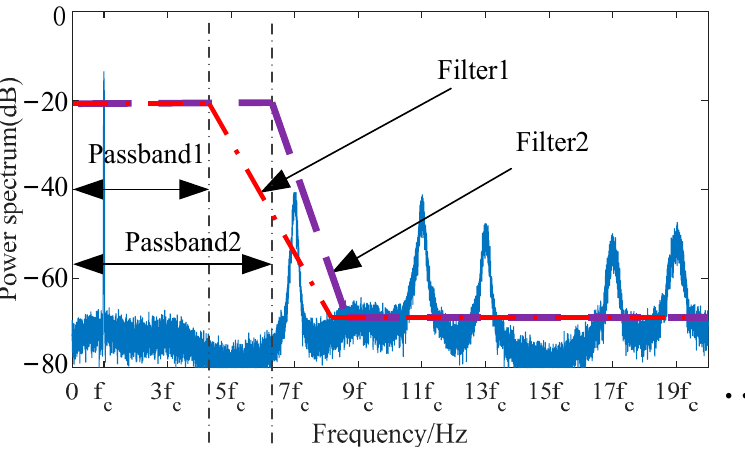
Table 2. Performance Comparison for SI, SII and SIII under the 16QAM Input Signal at 200 MHz Carrier with T r = 1%. Figure 8. Simulated spectrum of the proposed method for the 16QAM input signal at 200 MHz carrier with T r = 1%.